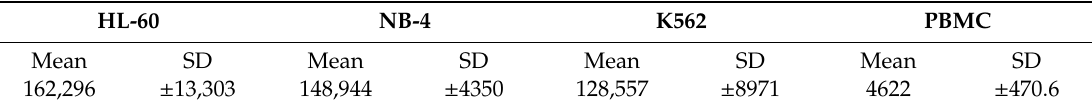
Table 1. KCTD15 intensity of expression (mean +/ − SD) in circulating HL-60, NB-4, and K562 AML cell lines and PBMC.